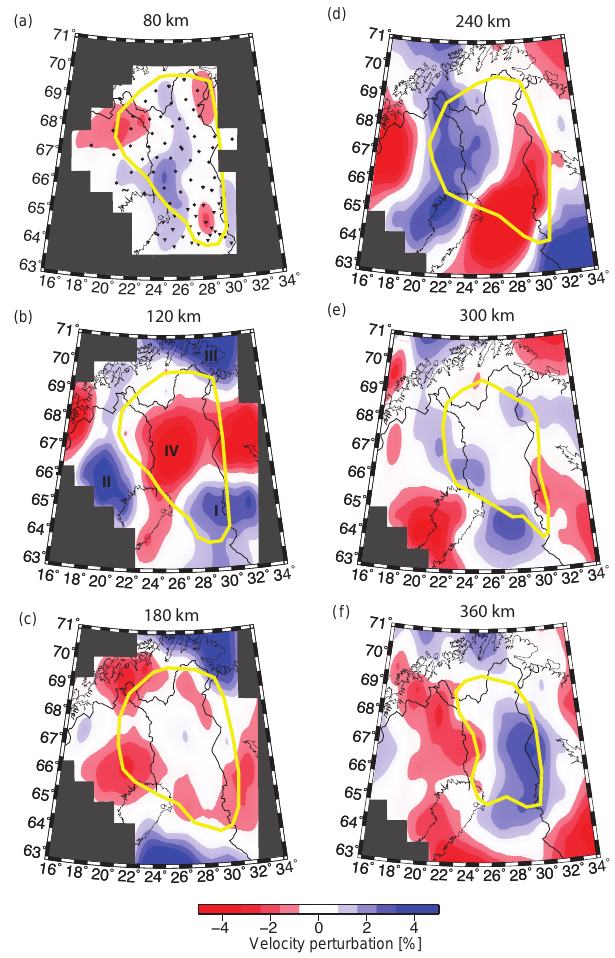
Figure 10. Horizontal sections through our final inversion result. The depth of each section is marked above each plot. The grey cor- ners show areas that were crossed by no rays and consecutively were excluded from inversion. The Roman numbers in (b) are referred to in the text when discussing the